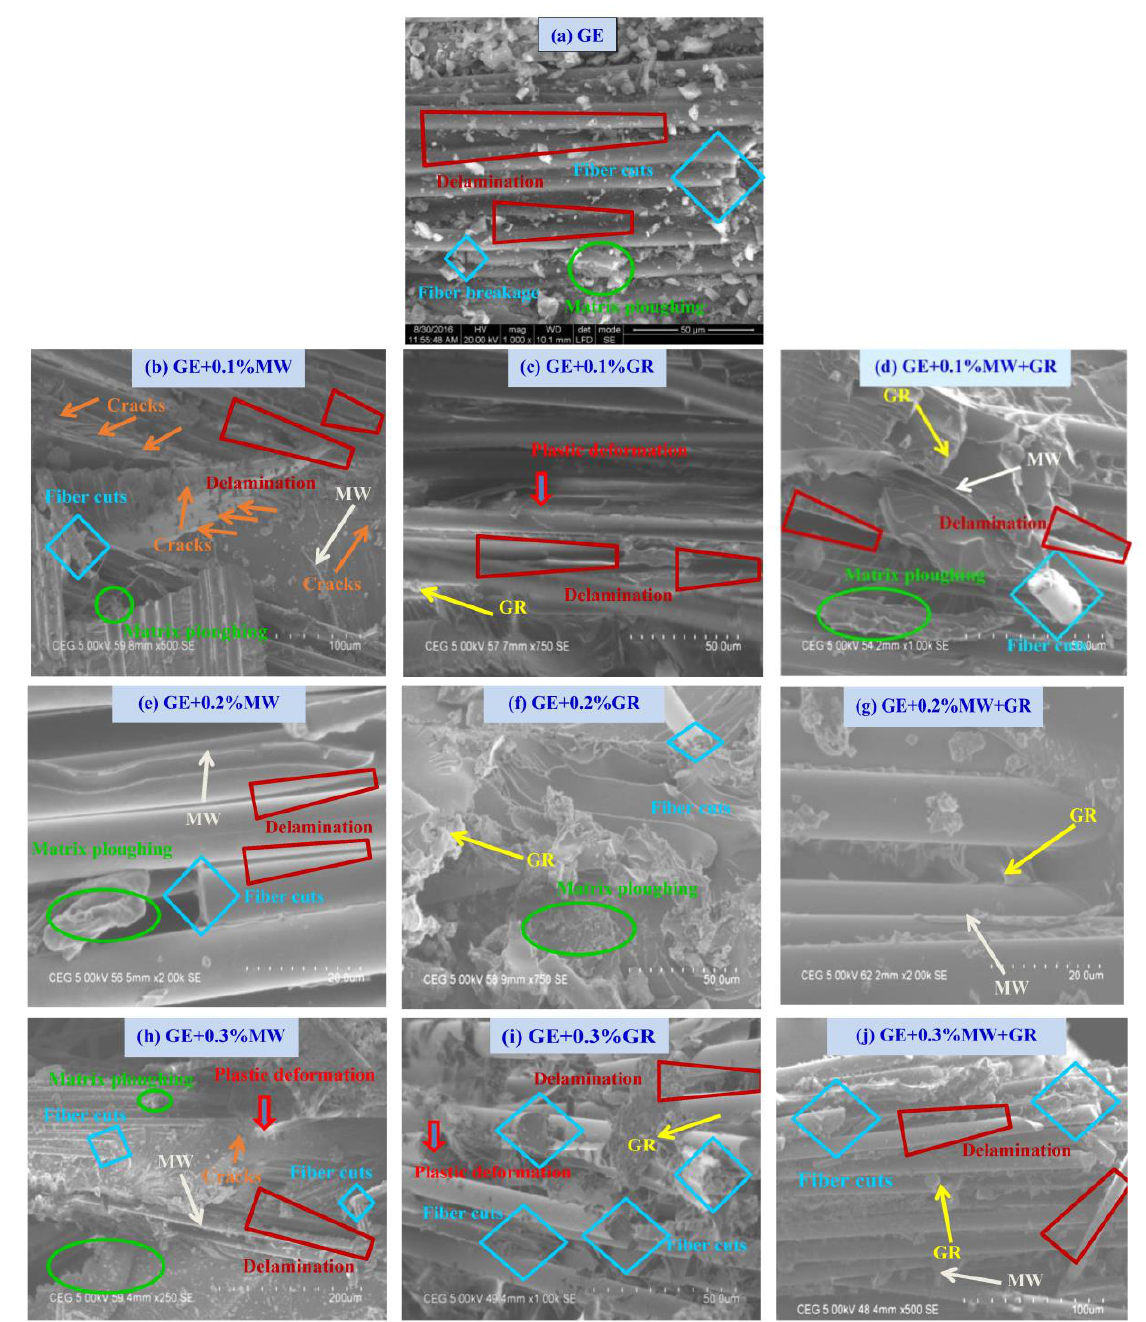
Figure 17. SEM micrographs of interlaminar shear failure in GE and its nanocomposites